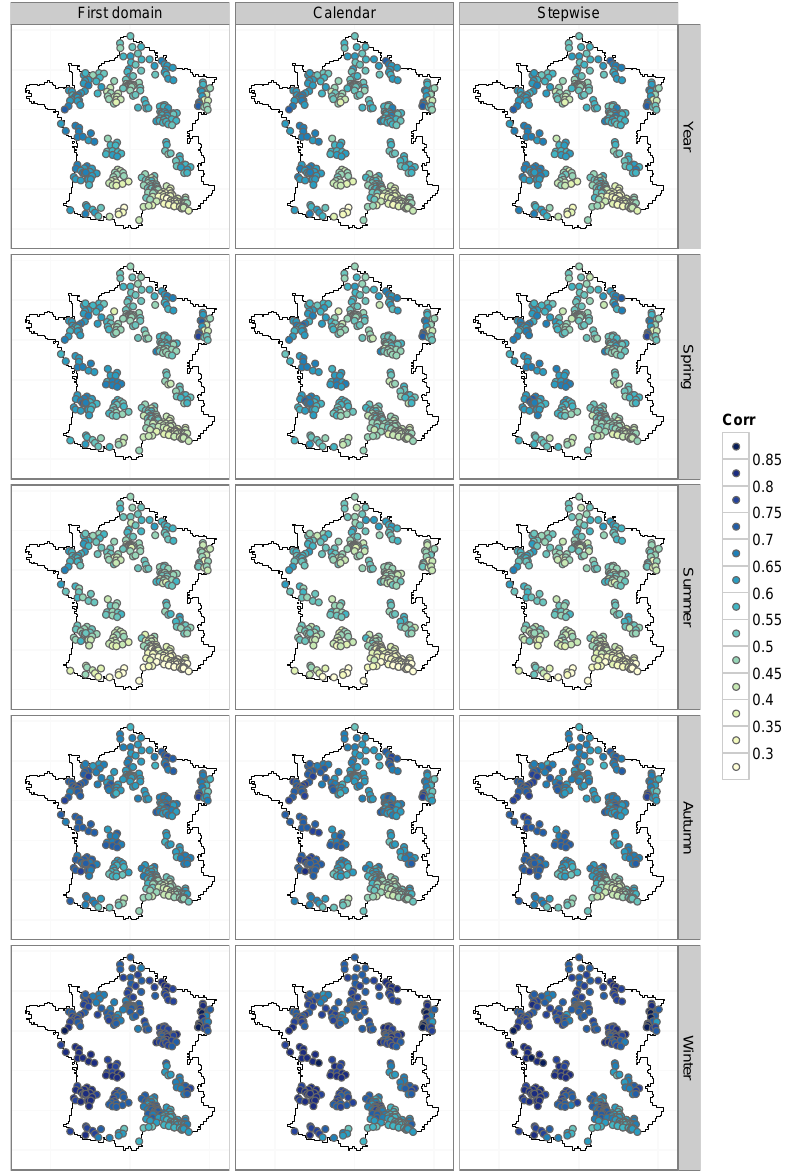
Figure 12. As for Fig. 11 but for precipitation. Minimum correlation of 0.10 for the calendar selection in summer and maximum correlation of 0.91 for the first domain selection in